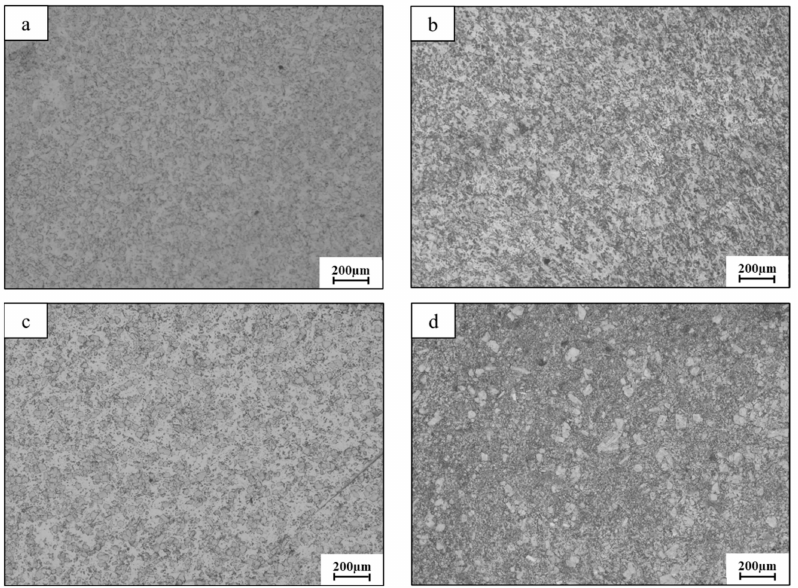
Figure 2. Optical microscopy in post extrusion process condition of Zn-2%Fe with up to 0.8% Mn: